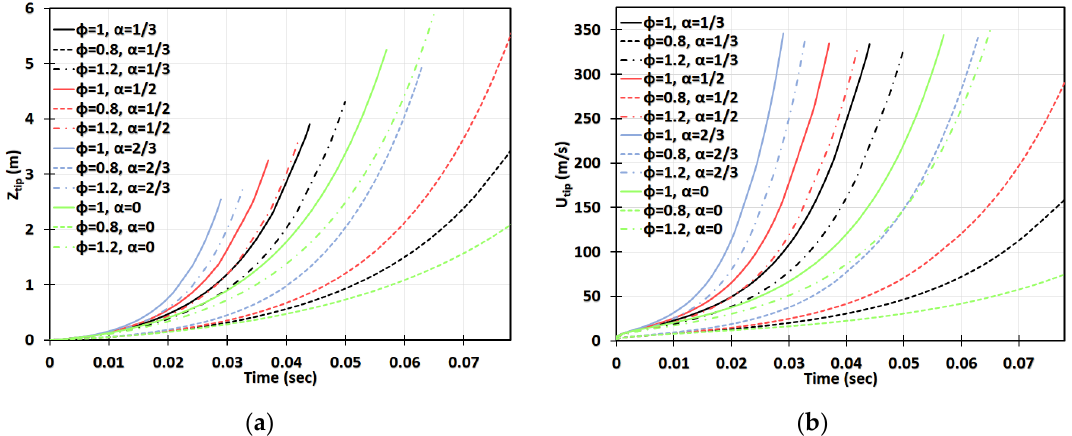
Figure 8. Time evolution of the flame tip position (cid:1852) (cid:3047)(cid:3036)(cid:3043) ( a ) and velocity (cid:1847) (cid:3047)(cid:3036)(cid:3043) ( b ) in a cylindrical- Figure 8. Timeevolutionoftheflametipposition Z tip ( a )andvelocity U tip ( b )inacylindrical-axisymmetric axisymmetric geometry for lean ( (cid:2038) = 0.8 ), stoichiometric ( (cid:2038) = 1 ), and rich ( (cid:2038) = 1.2 ) CH 4 -air burning geometry for lean ( φ = 0.8), stoichiometric ( φ = 1), and rich ( φ = 1.2) CH 4 -air burning with various with various blockage ratios (cid:2009) = 0, 1 3,⁄ 1 2,⁄ 2 3⁄ . blockage ratios α =